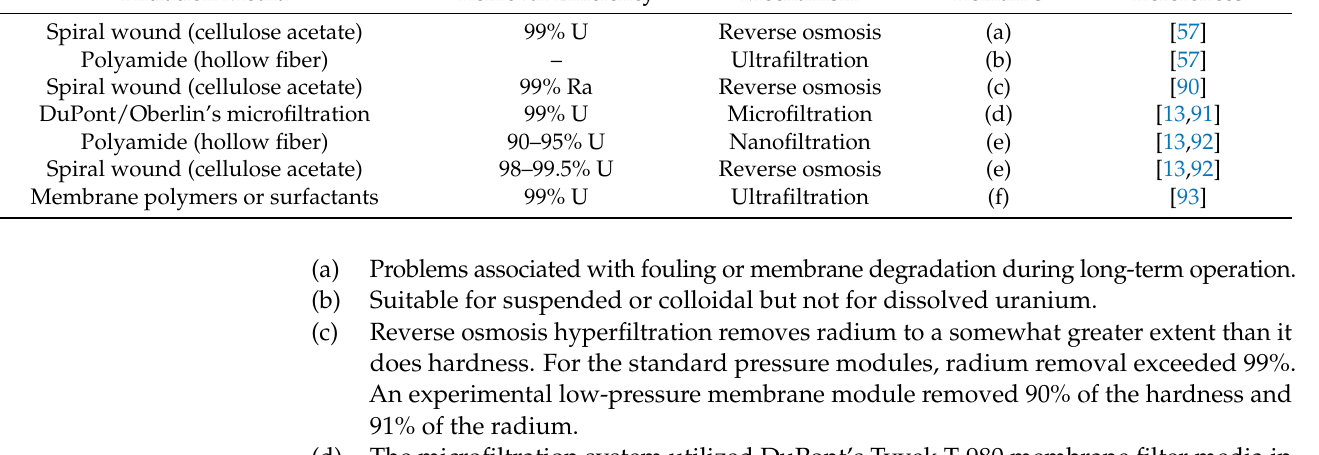
Table 4. Summary of the membrane filtration performance for uranium and radium removal. Filtration Media Removal Efficiency